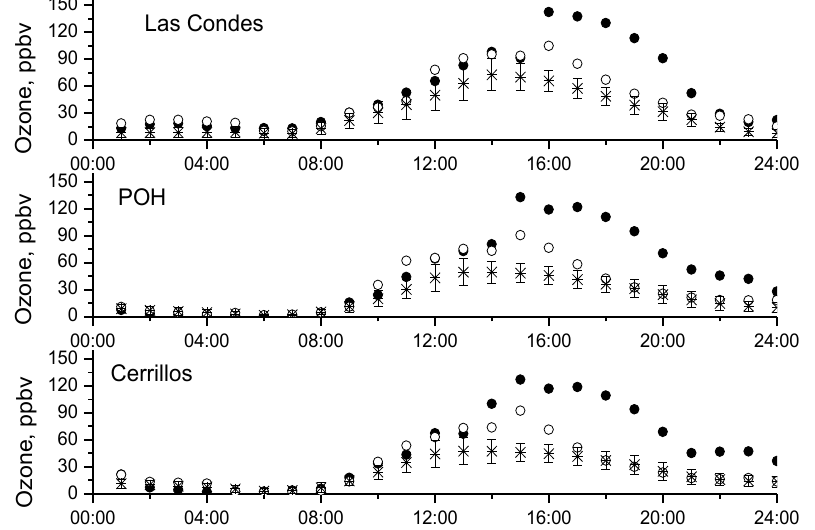
Figure 8. Ozone time profiles in background reference days ( ∗ ) and days with active fires in Melipilla region ( ○ ) (•).